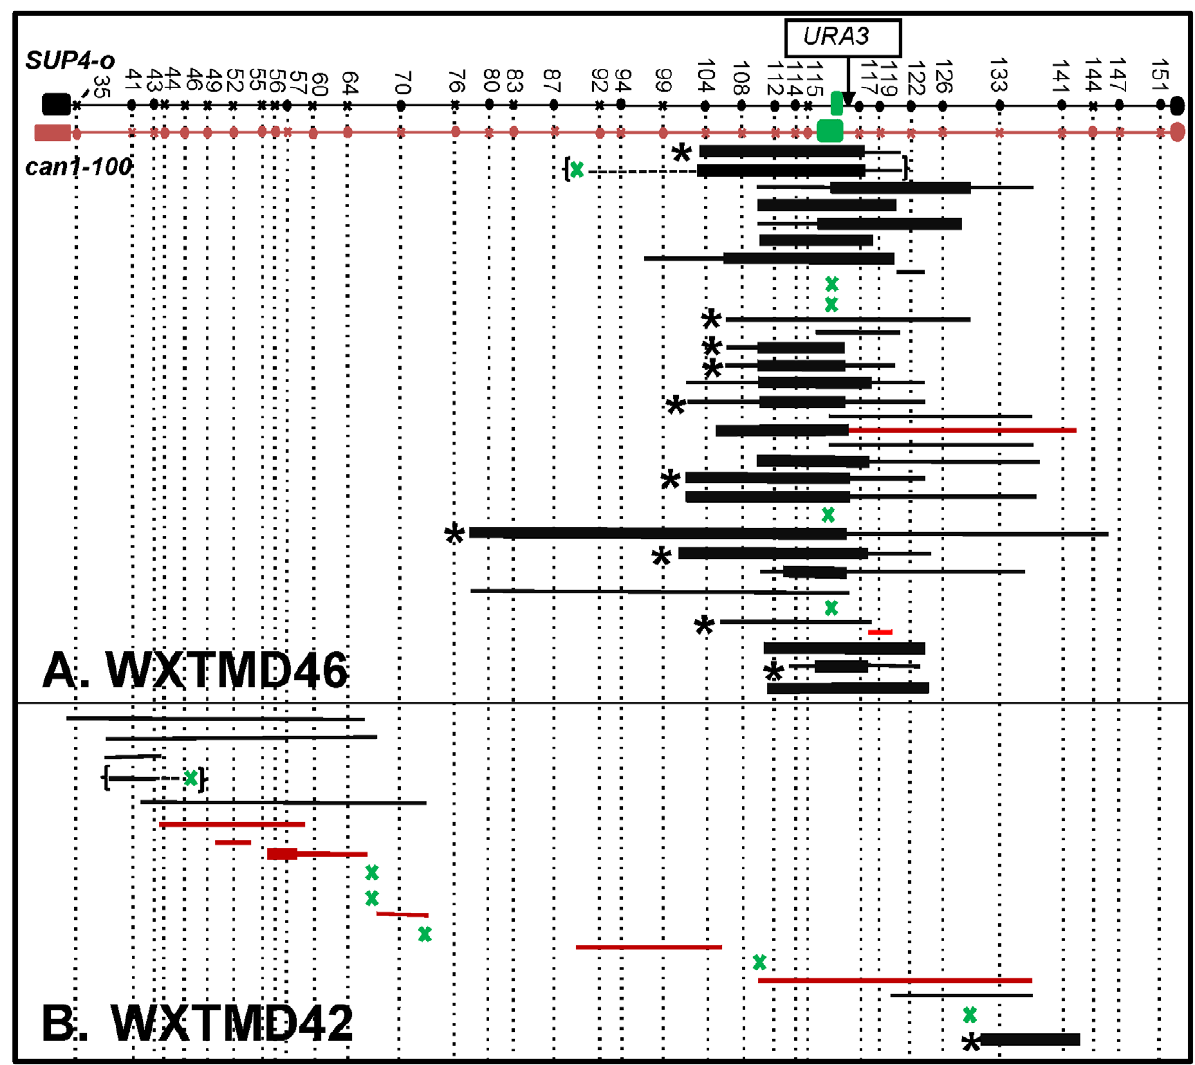
Figure 4. Mapping of RCOs and associated gene conversion events in WXTMD46 (GAA 230 /GAA 20 ) and in WXTMD42 (GAA 20 /GAA 20 ). The two horizontal lines at the top of the figure represent the two copies of chromosome V of the diploids with black showing the chromosome derived from the haploid PSL5/YJM789 background and red indicating the chromosome derived from PSL2/W303a. The green boxes show the position and approximate sizes of the (GAA) n tracts in WXTMD46. In WXTMD46, the ‘‘black’’ chromosome contains the GAA 20 tract and the ‘‘red’’ chromosome has the long GAA 230 tract; both tracts are short in WXTMD42. By PCR and restriction analysis [15], we determined whether the markers (shown as X’s and circles) were heterozygous or homozygous in each sector. At the top of the figure, an X indicates that the PCR fragment did not have the diagnostic restriction site, and a circle indicates that it had the site. The numbers show the approximate SGD coordinates of the marker in kb. The data from each colony are shown on a separate line. Conversion events of the 3:1 and 4:0 types are indicated by thin and thick lines, respectively. The color of the lines indicates whether the donated marker was from the black or red chromosomes. Green X’s show RCOs that are not associated with an observable gene conversion. A. Analysis of 33 sectored colonies of WXTMD46. In this strain, many of the conversion tracts were hybrid 3:1/4:0 events. In some of these events (marked with an asterisk), there was a crossover within the conversion tract. An example of one of these events is shown in Figure S1. Although most of the conversion events involve donating information from the black chromosome to the red chromosome, there were two conversions in which the transfer of information occurred in the opposite direction. There was also one example of a conversion event that was separated from the crossover by markers not involved in the conversion (shown as a green X connected to the conversion event by a dotted line). B. Analysis of 18 sectored colonies of WXTMD42. In this strain, as expected, the conversion and crossover events are distributed throughout the 120 kb interval between CEN5 and the can1-100/SUP4-o markers. chromosome V were homozygous for the PSL2 form of the heterozygous for a (GAA) 230 tract) and WXTMD42 (a diploid polymorphism (shown in red in Figure 4), the PSL5 form of the homozygous for [GAA] 20 tracts). polymorphism (shown in black in Figure 4), or were heterozygous. The positions of the crossovers and gene conversion events were In the previous studies of spontaneous or gamma-ray-induced mapped by the methods described previously [15]. In brief, using mitotic crossovers, four types of sectored colonies were commonly PCR and restriction analysis, for both sectors of a Can R red/white observed: 1) RCOs unassociated with an adjacent gene conversion sectored colony, we determined whether polymorphic sites on